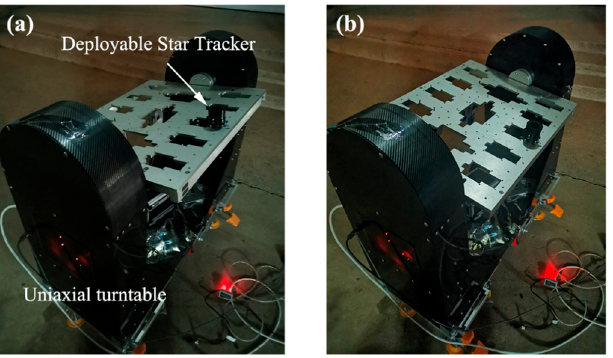
Figure 18. The dynamic performance experiment. ( a ) The turntable is at +10° . ( b ) The turntable is at −10° .